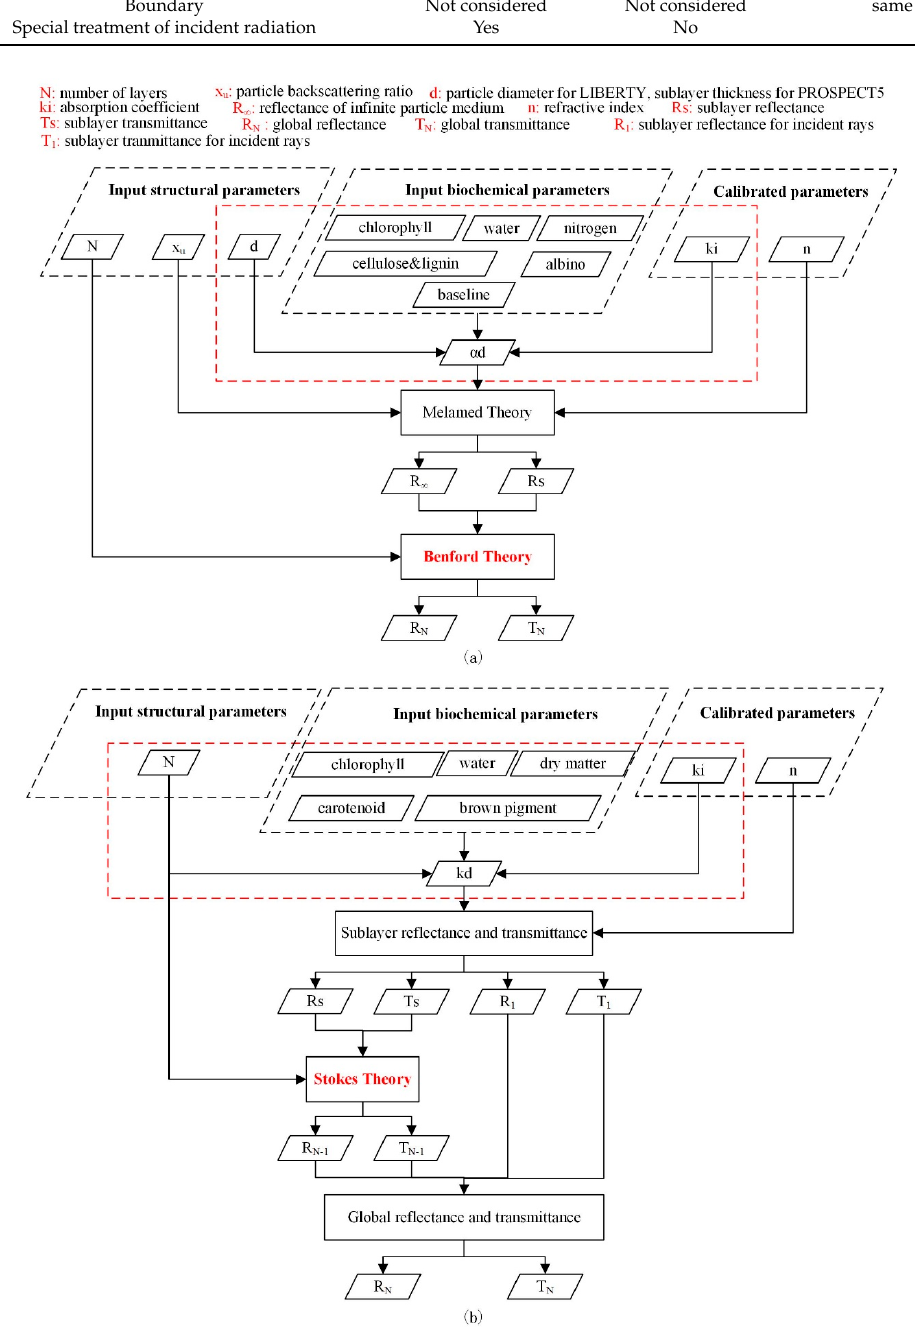
Figure 10. Mechanisms of the forward simulation of ( a ) LIBERTY and ( b ) PROSPECT5. The definitions of parameters are given in the top of ( a )